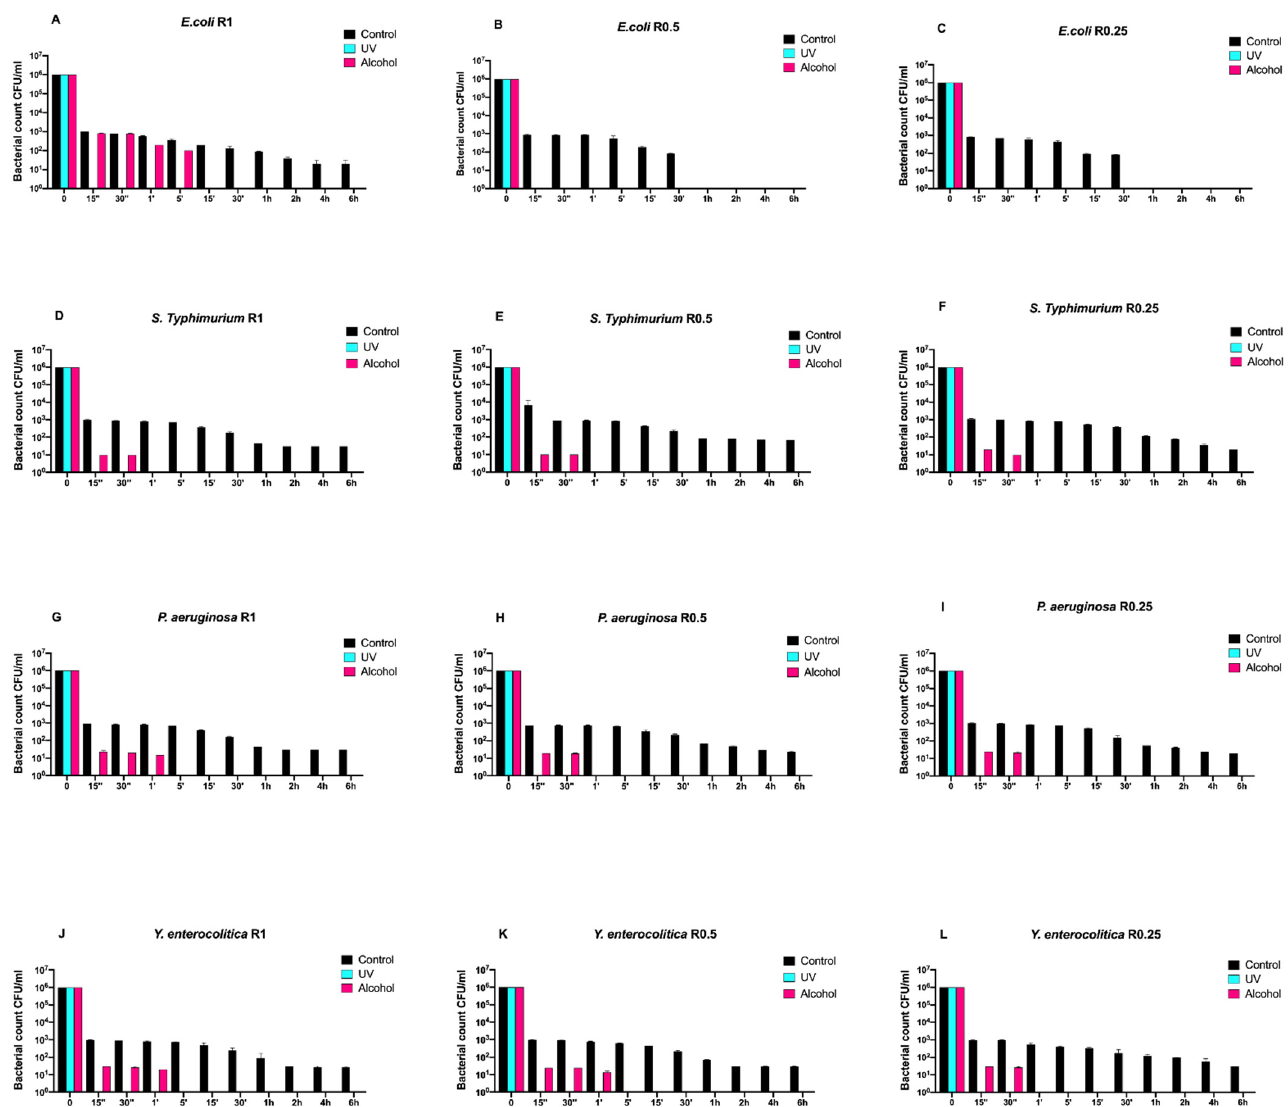
Figure 2. Graphical representation of the different exposure times of SiO x C y H z -coated disks with different surface rough- ness (R0.25, R0.5, and R1) unsanitized (control) and subjected to two sanitizing methods (UVC and alcohol) against ( A – C ) Escherichia coli ATCC 25922, ( D – F ) Salmonella Typhimurium ATCC 1402, ( G – I ) Pseudomonas aeruginosa ATCC 27588 and ( J – L ) Yersinia enterocolitica ATCC 9610.